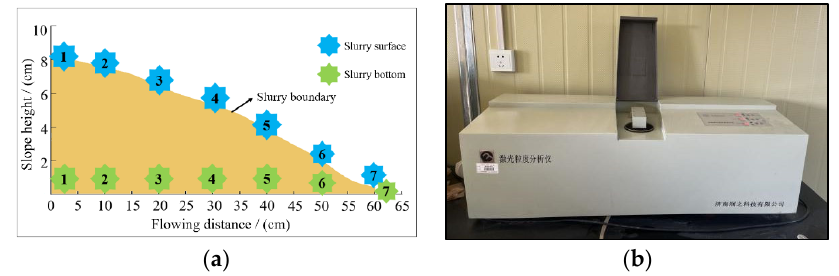
Figure 5. ( a ) Sampling location; ( b ) Laser particle size